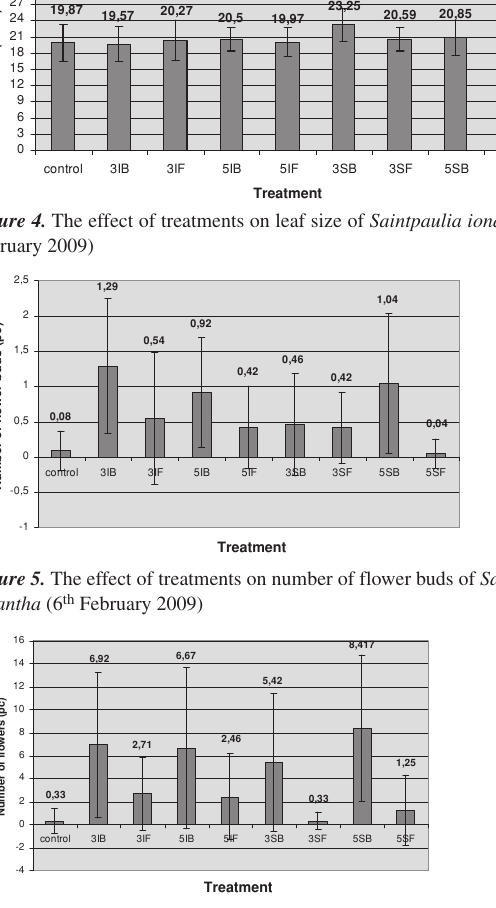
Figure 6. The effect of treatments on number of flowers of Saintpaulia ionantha (20 th February